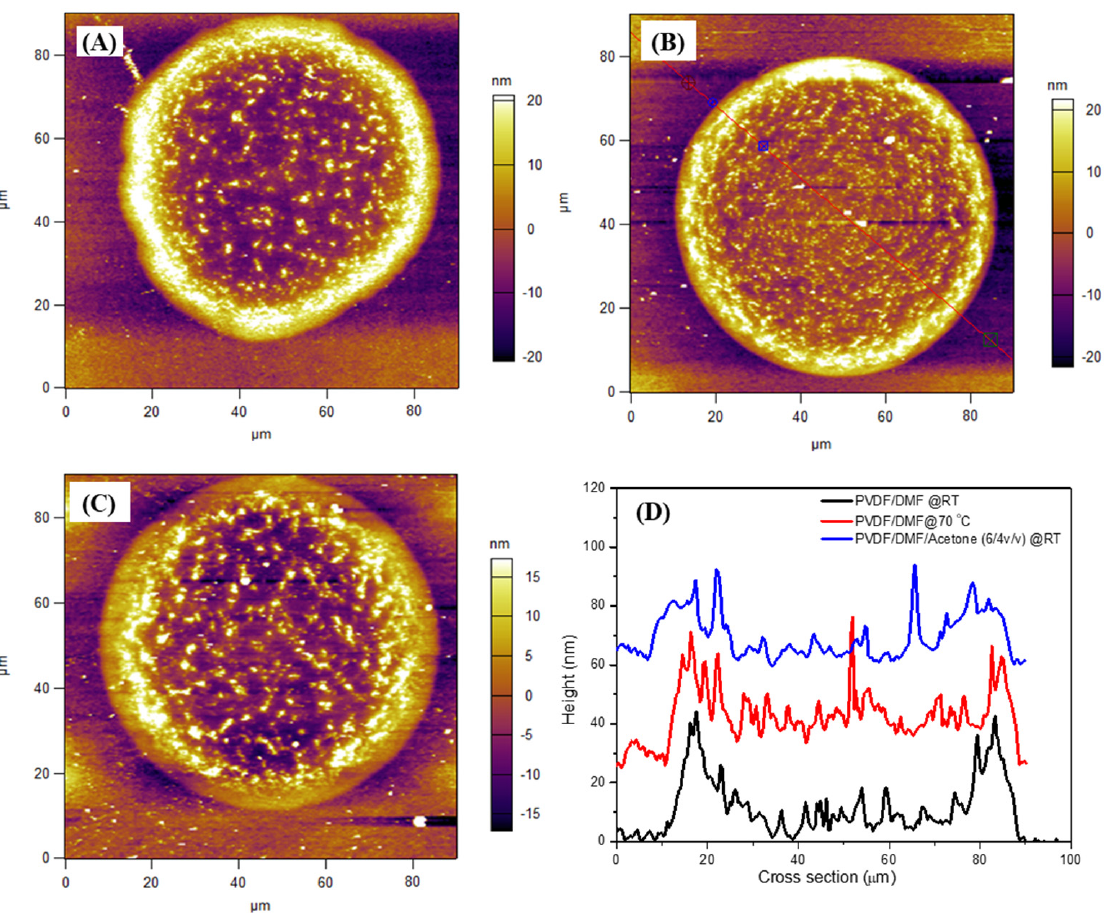
Figure 5. AFM height images of ( A ) PVDF/DMF solution S-droplets at RT, ( B ) PVDF/DMF solution S-droplets at 70 °C, ( C ) PVDF/DMF/acetone solution S-droplets at RT, ( D ) cross section profiles obtained from AFM images of ( A–C ).